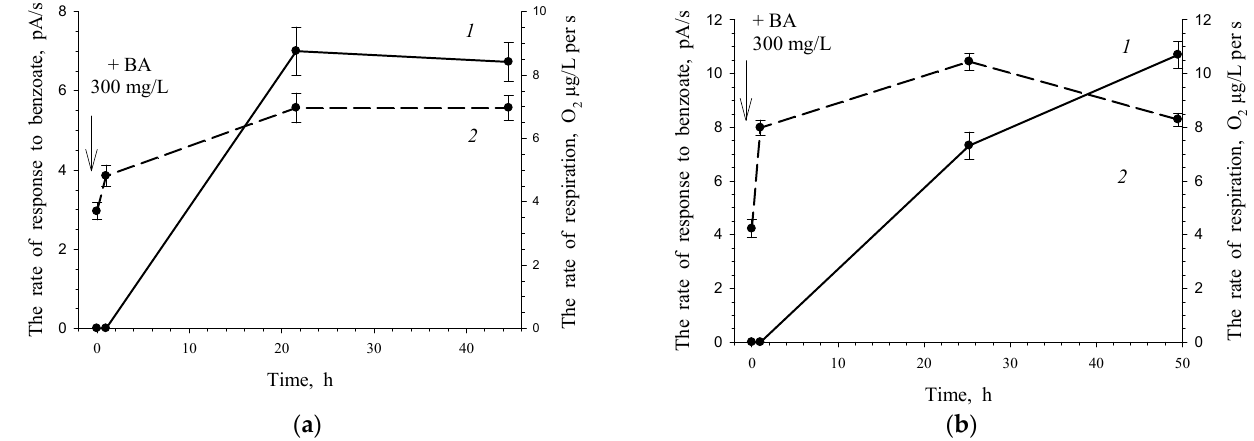
Figure 11. Response of G. polyisoprenivorance 135 cells toward benzoate under non-growth conditions. ( a ) 1 —Activity of BDO toward 3.47 mM benzoate; 2 —consumption of O 2 without a substrate. ( b ) Response of the same cells to a second portion of benzoate 7 days after the first one. 1 —Activity of BDO toward 3.47 mM benzoate, 2 —consumption of O 2 without a substrate.